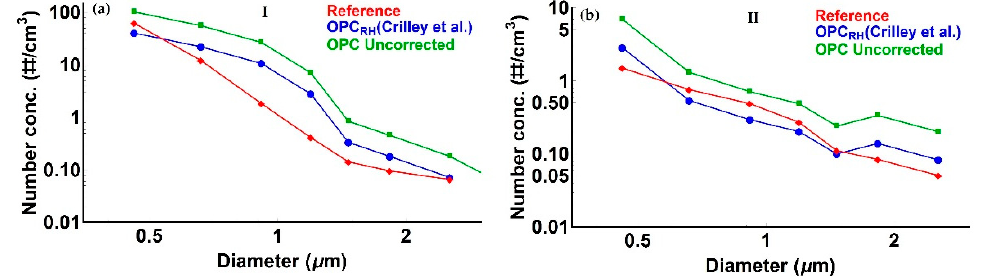
Figure 2. Particle size distributions for ( a ) period I in Figure 1 and ( b ) period II in Figure 1. Uncorrected Alphasense OPC-N2 particle size distributions are shown in green. Particle size distributions after application of the Crilley et al. correction factor (assumed to be constant across the size spectrum) are shown in blue, and reference data in red. See text for discussion.